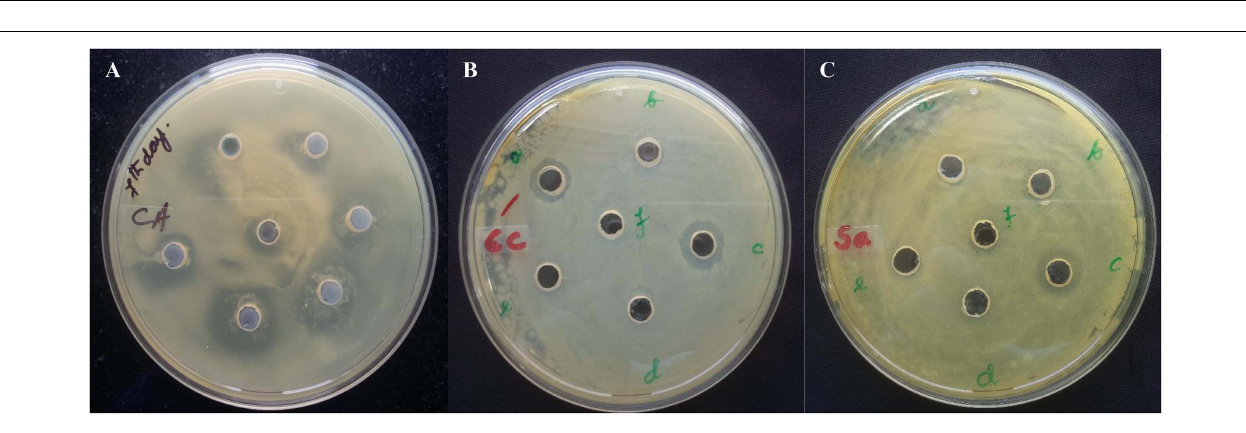
enriched from the fermentation broth of P. peoriae